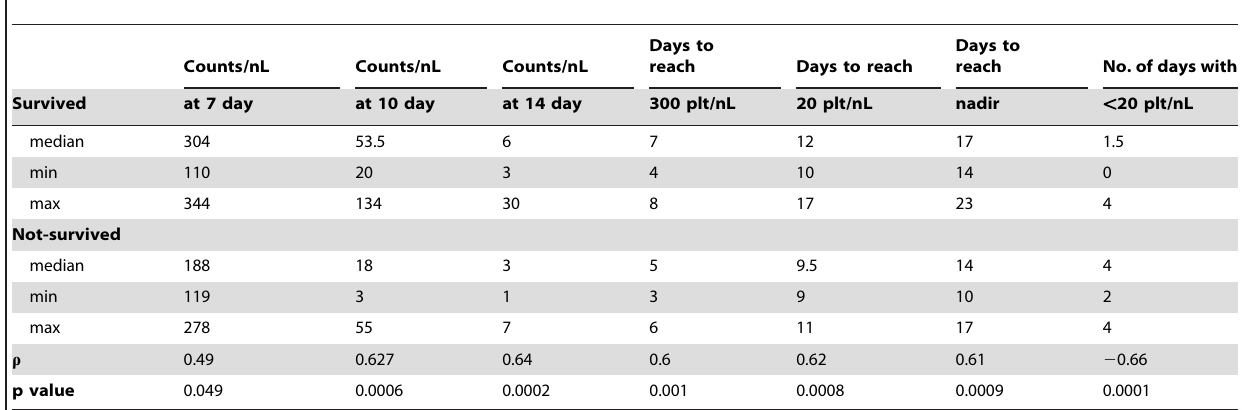
Table 3. Spearman rank correlation ( r ) of platelet counts-based parameters with survival in irradiated G. minipig (n=